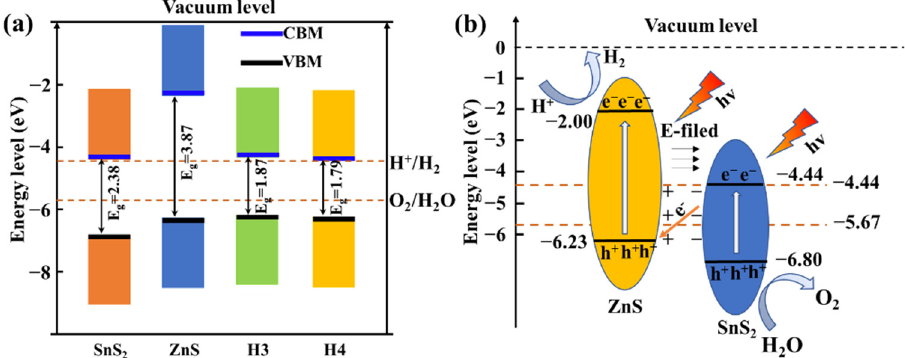
Figure 7. Schematic presentation of the band edges with respect to the vacuum level of the SnS 2 layer, ZnS layer, and heterojunctions, as well as the reduction (H + /H 2 ) and oxidation (O 2 /H 2 O) potentials at pH = 0 ( a ). Schematic diagram of photocatalysis of H4 model Z-scheme mechanism ( b ).